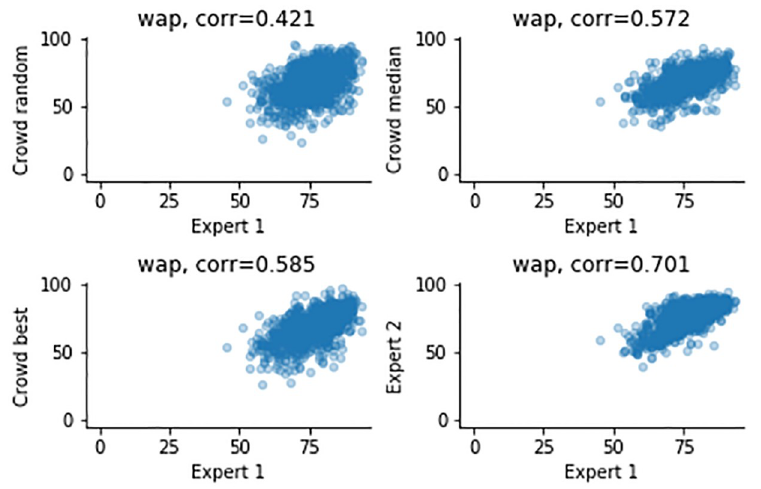
Fig 8. Measurements of the WAP, comparing expert 1 (x-axis) and to three combining methods and expert 2 (y- axis).